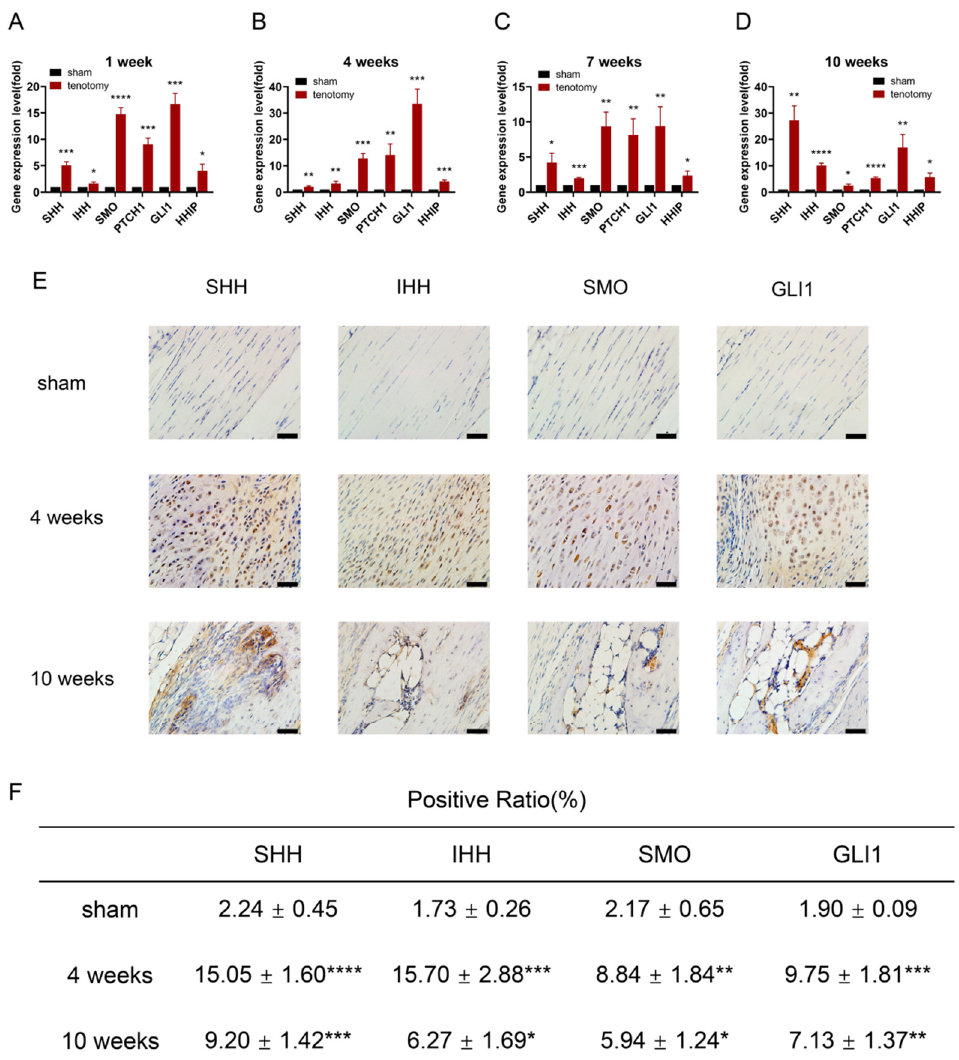
Figure 2. Hedgehog signalling is upregulated in tendons after Achilles tenotomy. ( A – D ) qRT–PCR analysis of the Hh signalling-related molecules SHH, IHH, SMO, PTCH1, GLI1, and HHIP in healthy and tenotomy groups at 1 ( A ), 4 ( B ), 7 ( C ), 10 ( D ) weeks. ( E ) Images of immunohistochemical staining of SHH, IHH, SMO, and GLI1 in the healthy and tenotomy groups at 4 and 10 weeks. Scale bar = 20 μ m. ( F ) Quantification of immunohistochemical staining of SHH, IHH, SMO, and GLI1. * p < 0.05, ** p < 0.01, *** p < 0.001, **** p < 0.0001.